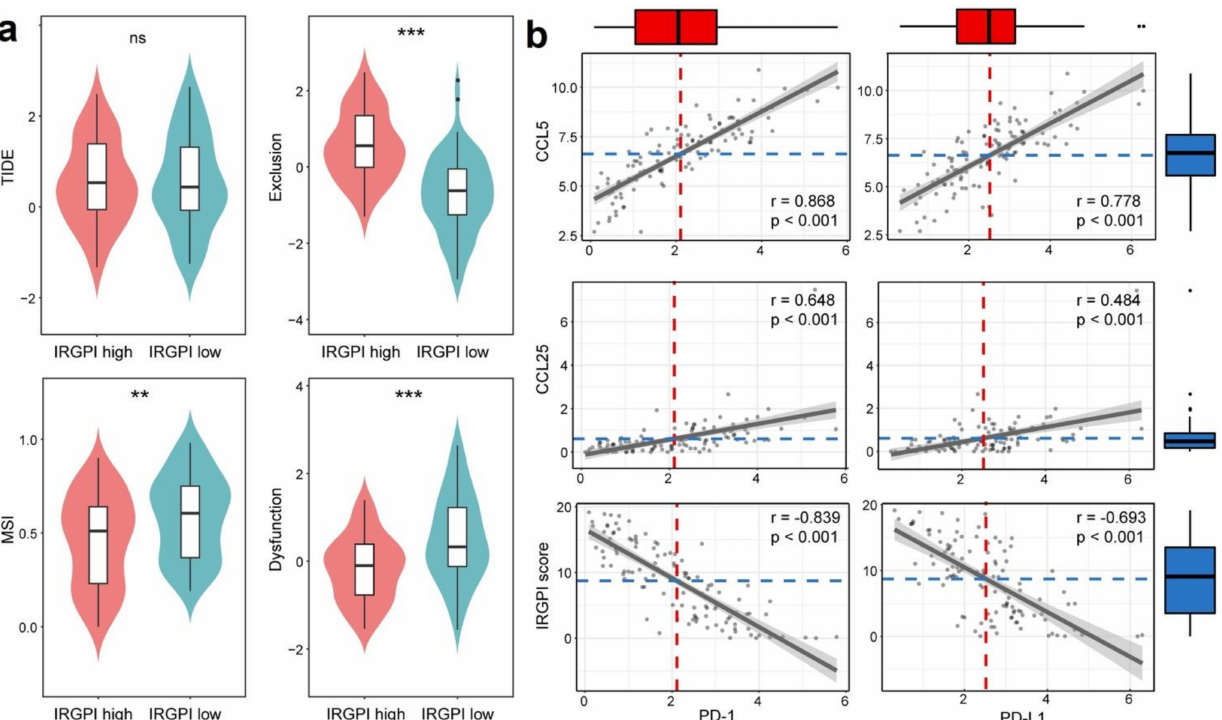
Figure 6. IRGPI is associated with T-cell exclusion and dysfunction, and PD1 and PD-L1 expression in TNBC of TCGA data set. ( a ) Scores of TIDE, MSI, and T-cell exclusion and dysfunction in different IRGPI risk groups (ns: not significant, ** p < 0.01; *** p < 0.001); ( b ) Correlation between CCL5/CCL25/ IRGPI scores and